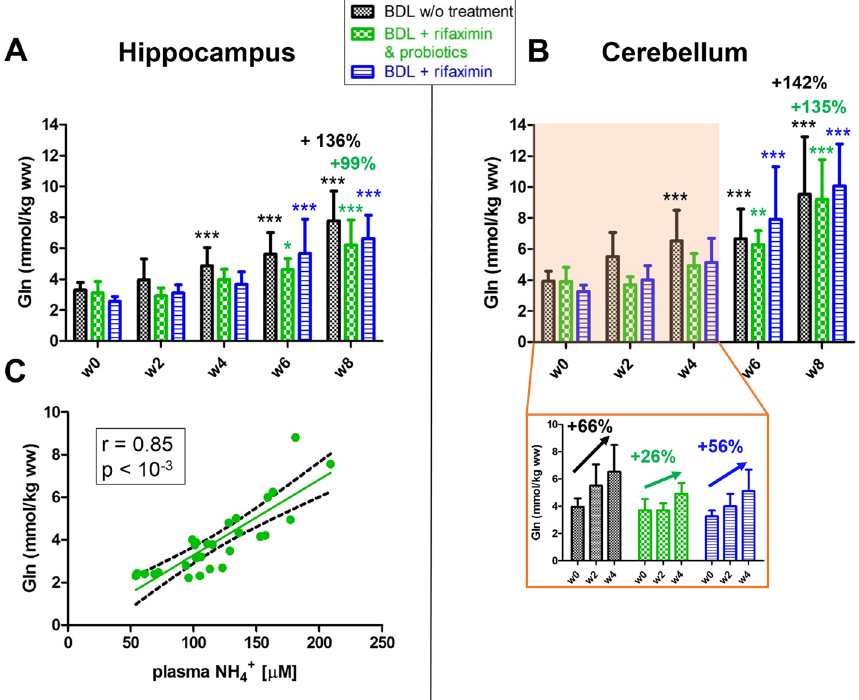
Figure 3. Brain Gln in the hippocampus ( A ) and in the cerebellum ( B ) from week 0 to week 8 in the three groups. Statistical significance intra-group reported: one-way ANOVA (* p < 0.05; ** p < 0.01; *** p < 0.001). The relative increases shown are relative to week 0. ( C ) Correlation between brain Gln in the hippocampus and plasma ammonium in rats treated with the combination of rifaximin and